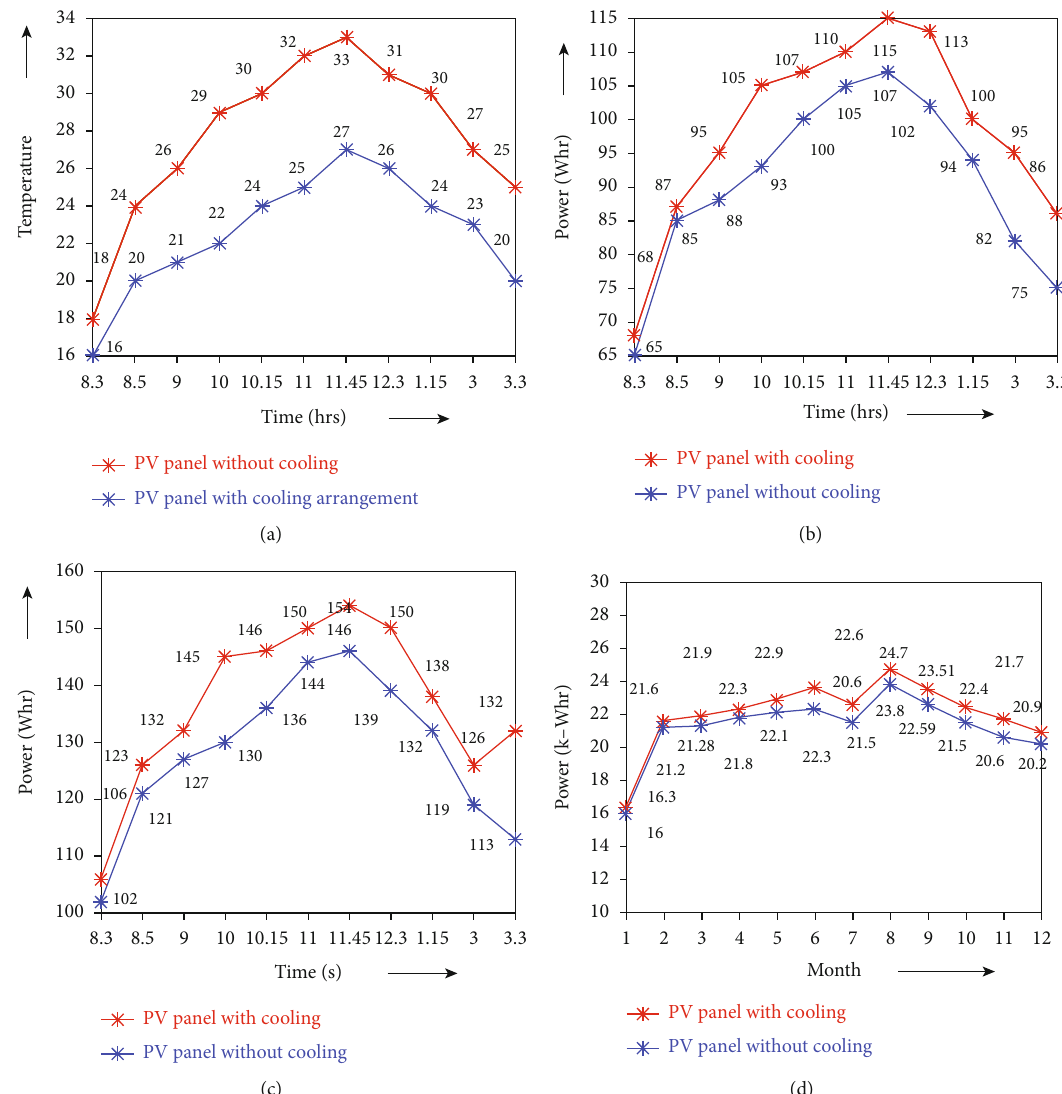
Figure 12: (a) Thermal characteristics of solar panel in the month of August. (b) Power generation in the month of January. (c) Power generation in the month of June. (d) Overall power generation for a